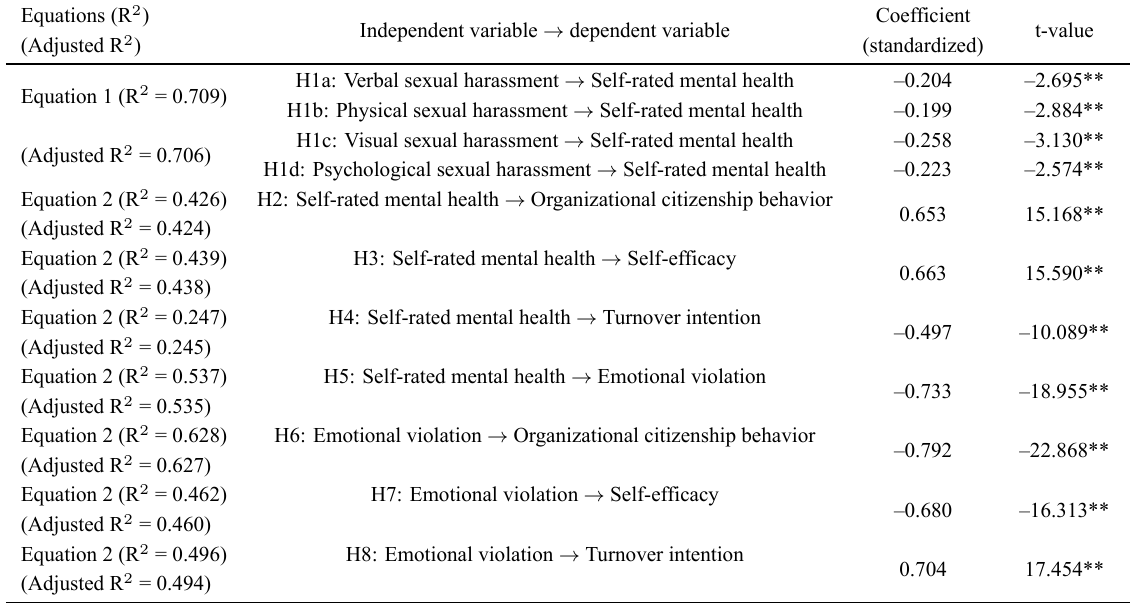
Fig. 2. Results of structure model estimation. Table 4. Results of the regression